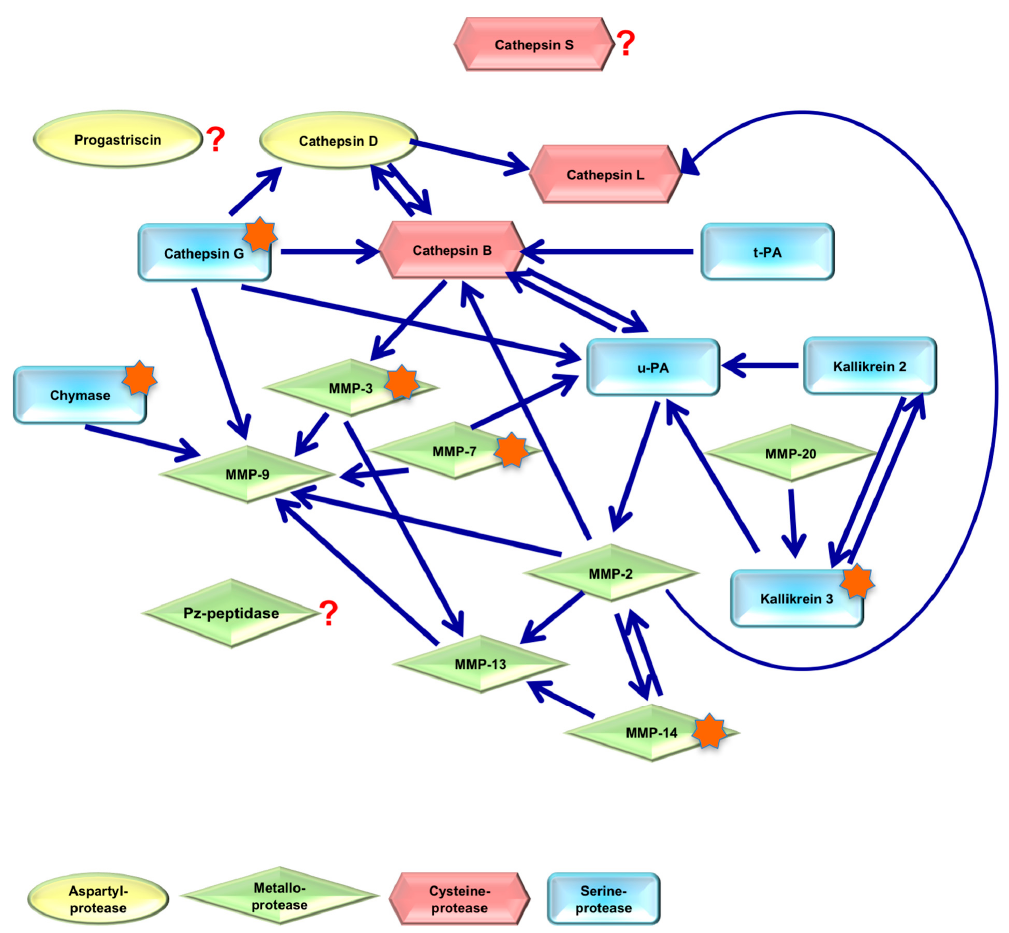
Figure 7. Proteolytic network in human seminal plasma. The role of some enzymes in liquefaction cascade is still obscure (?).